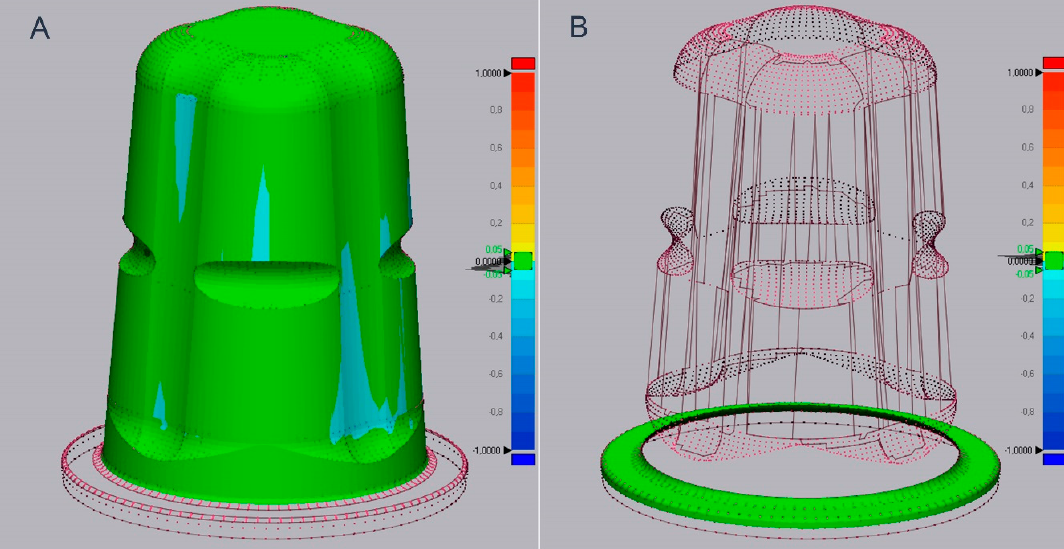
Figure 6. Representative measurements of OC 2 with a tolerance of ± 50 μ m (green regions) for ( A ) circumferential deviations and ( B ) marginal deviations.